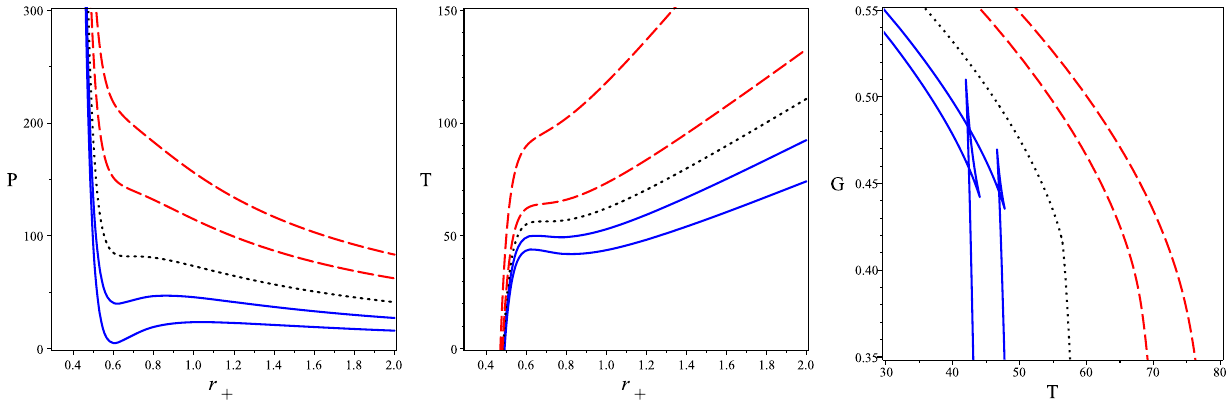
Fig. 21 ColdhyperbolicblackholeinLMgravity: P − r + (left), T − r + (middle) and G − T (right) diagrams; we have set k = − 1, d = 8, q = 1, m = 1, c 0 = c 1 = c 2 = c 3 = c 4 = 1 and α = 0 . 01. Left panel: